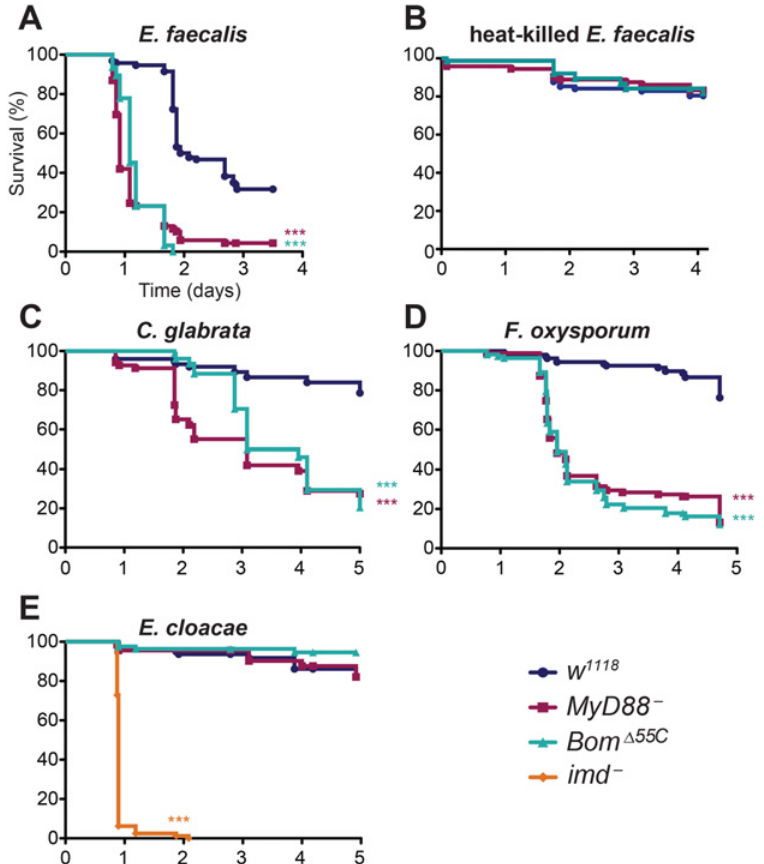
Fig 2. The 55C Boms are essential for Toll-mediated defense. Graphs indicate survival at indicated intervals post-infection with (A) E . faecalis , (B) heat-killed E . faecalis , (C) C . glabrata , (D) F . oxysporum , and (E) E . cloacae . Each curve represents the pooled results of at least three independent experiments involving 20 or more flies per genotype. Survival curves were compared using the Gehan-Breslow-Wilcoxon test. Significance is shown relative to the wild type ( w 1118 ) and adjusted for multiple comparisons ( *** p < 0.0003, n.s. = not significant, p > 0.0167).